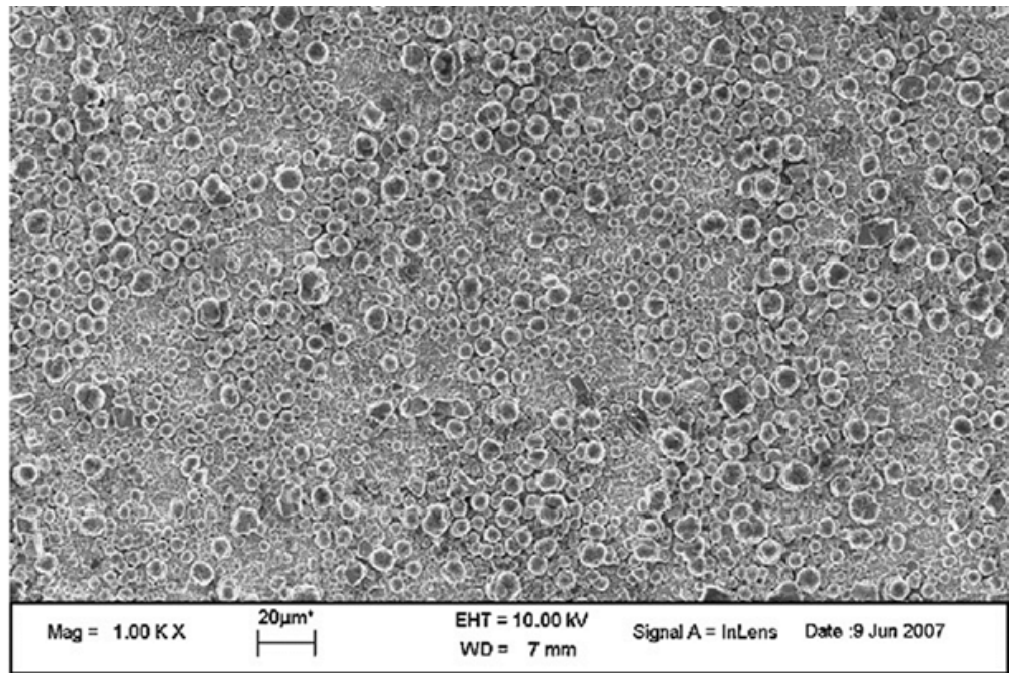
Figure 13. SEM image of the copper surface electroplated at the current density of 0.08 A/cm 2 . Images reprinted from [114], with permission from Elsevier, Copyright